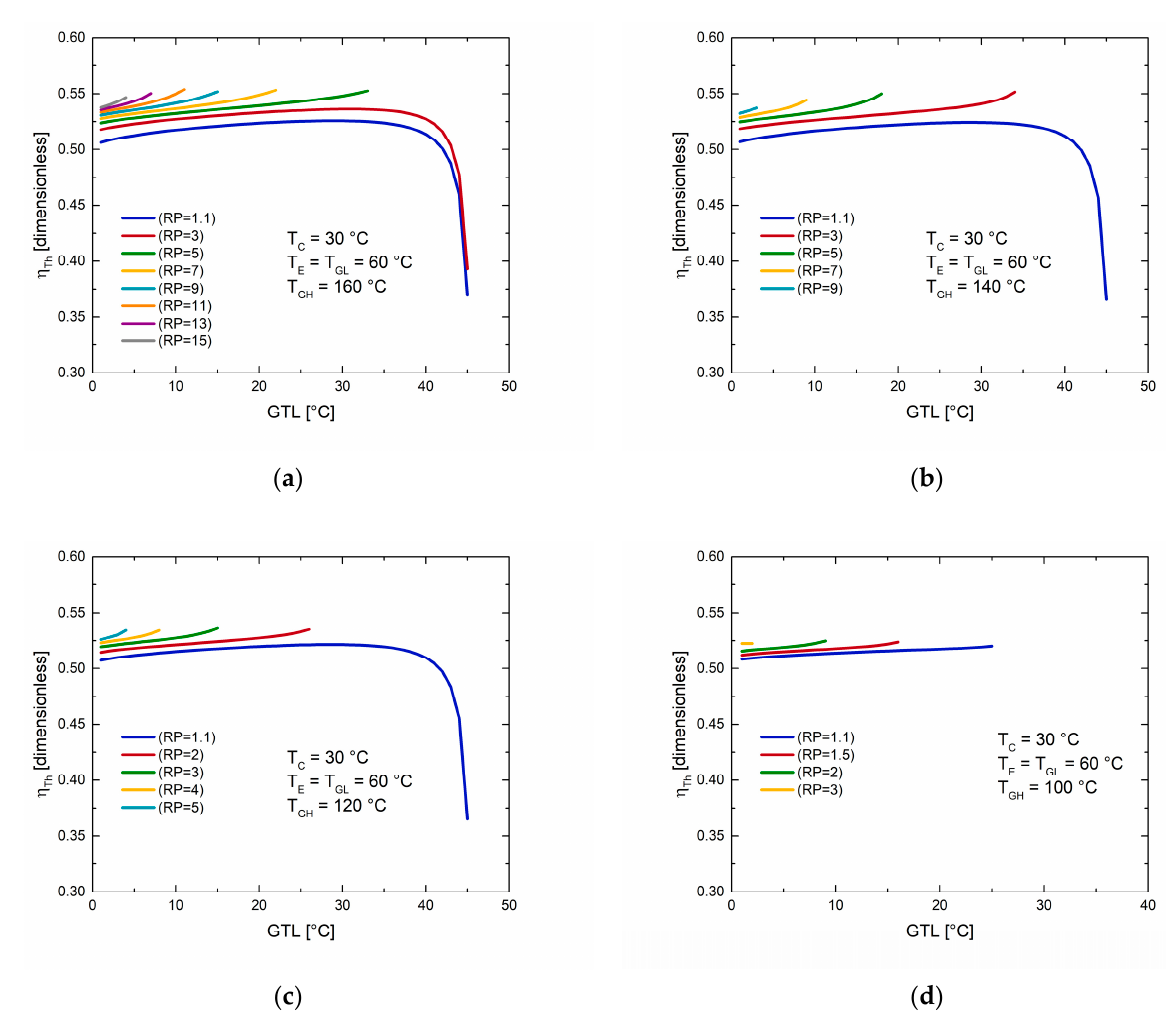
Figure 5. Thermal efficiency ( η Th ) as a function of GTL at different pressure ratios (RP). ( a ) T GH = 160 ◦ C; ( b ) T GH = 140 ◦ C; ( c ) T GH = 120 ◦ C; ( d ) T GH = 100 ◦